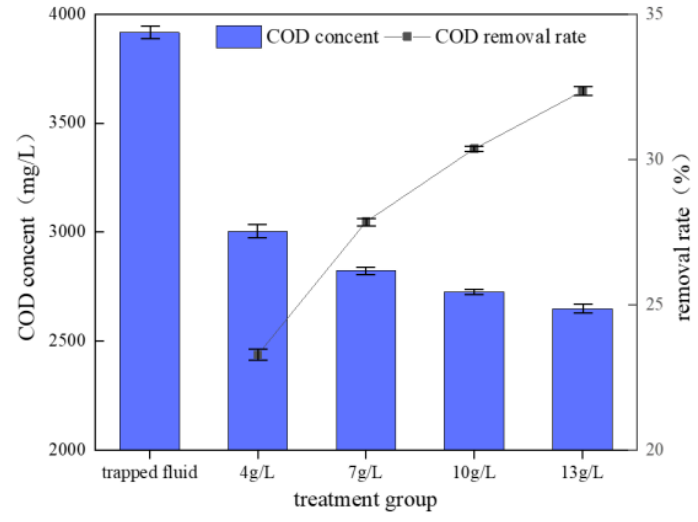
Figure 5. Effects of biochar absorption on COD.